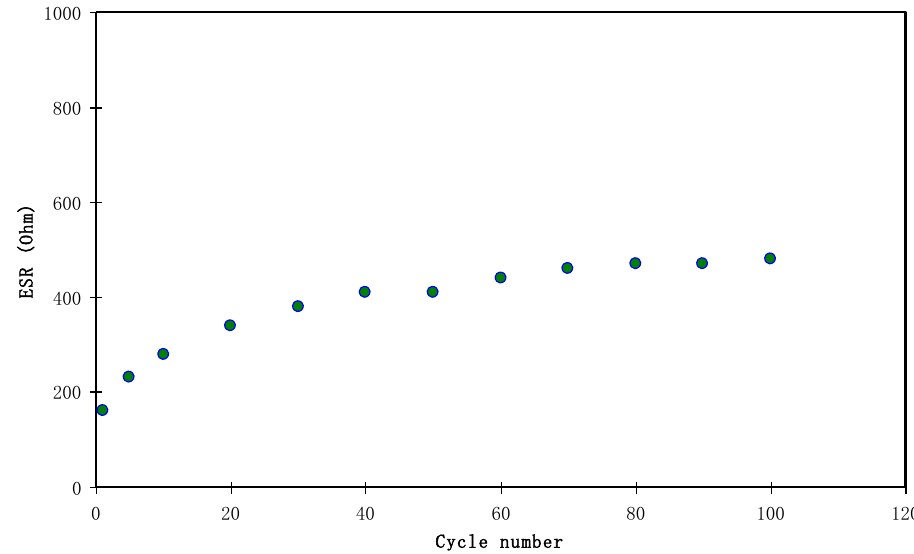
Figure 12. The pattern of equivalent series resistance of the EDLC for 100 cycles.